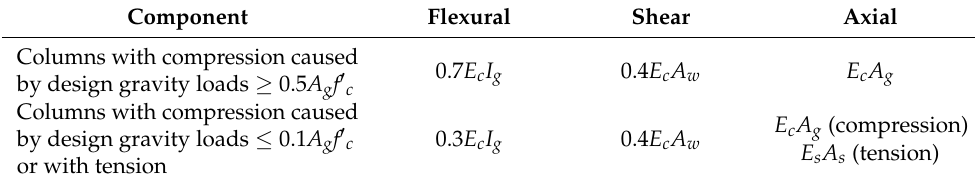
Table 4. Effective rigidity values (ASCE/SEI 41-17